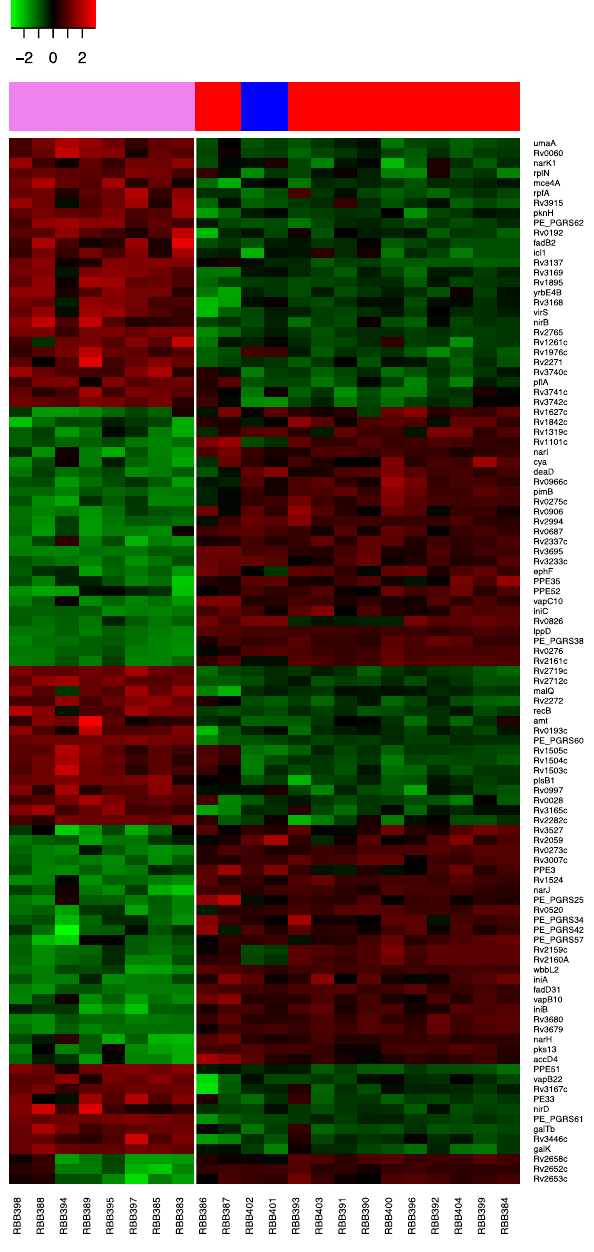
Figure 2. Gene expression differences between modern (lineage 2 and 4) and ancient (lineage 1) strains. A heatmap showing the 105 genes differentially expressed between ancient and modern strains, constructed with the gene expression distances between rows. Rows and columns are ordered based on row or column means. Over-expressed genes are coloured in red whilst under-expressed ones in green. Ancient strains (n = 8) represented on the left of the white vertical line and modern strains (n = 14) on the right. Lineage 1 represented in violet, Lineage 2 in blue and Lineage 4 in